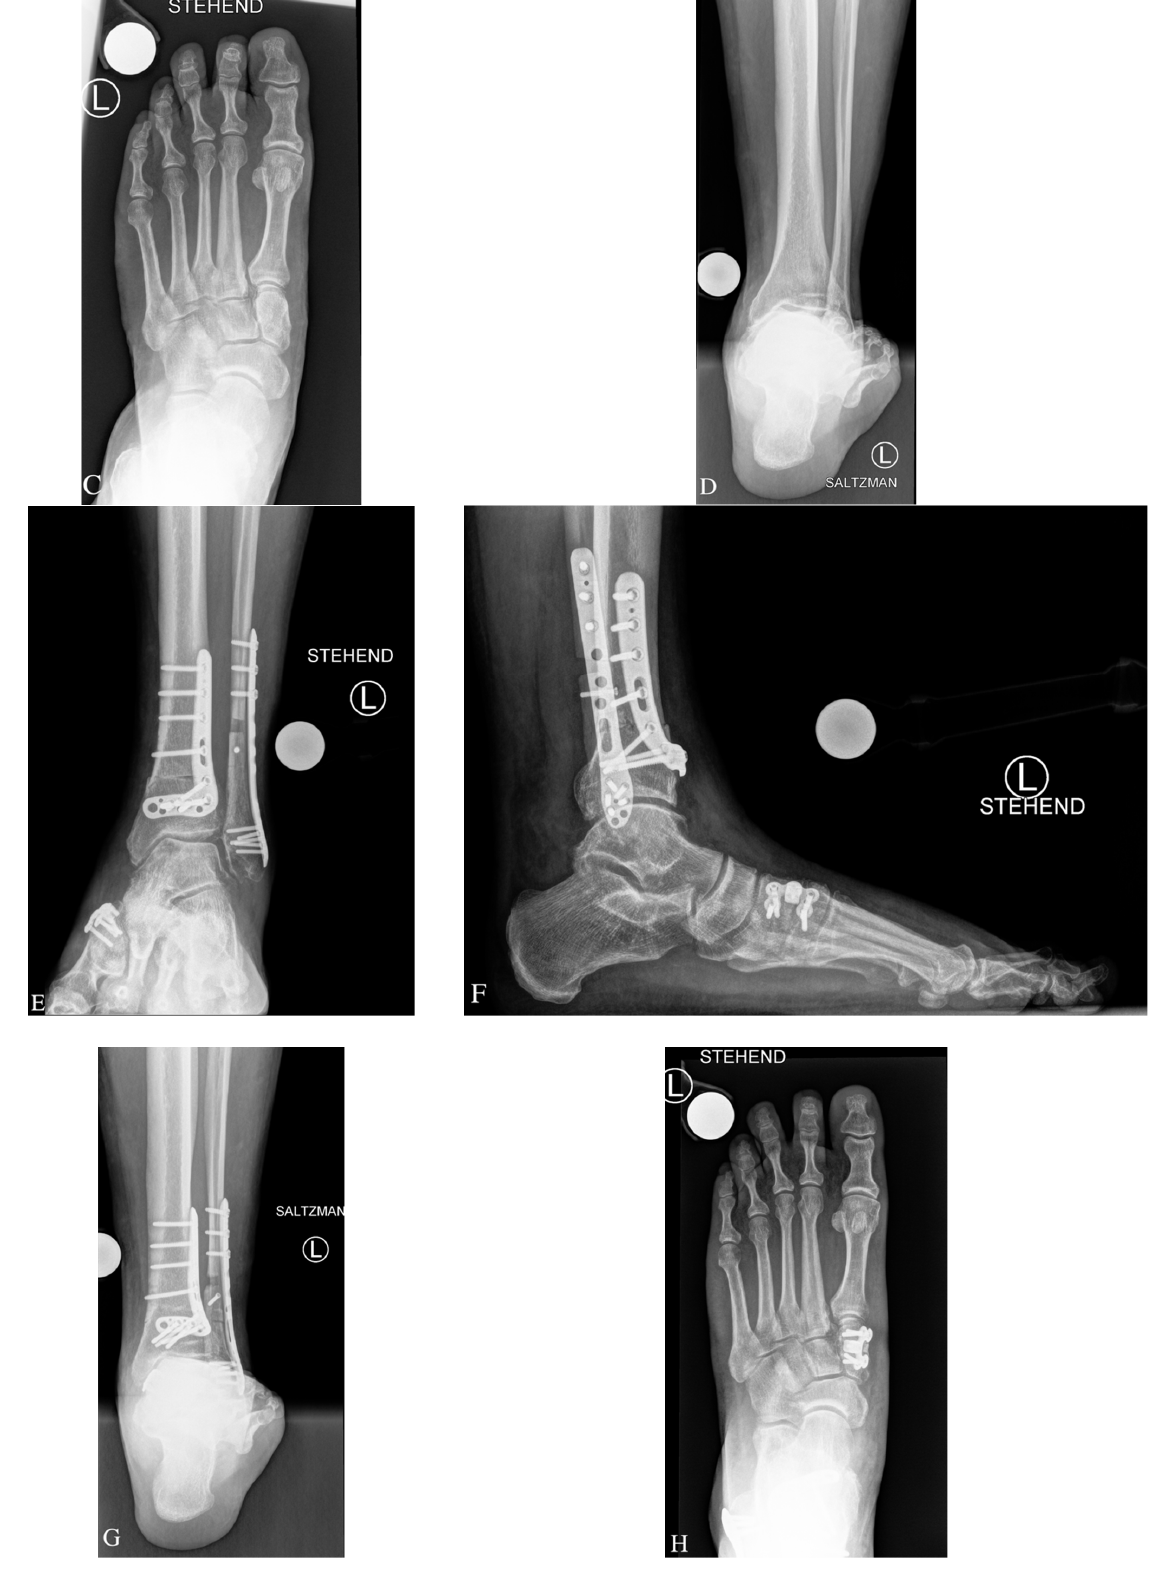
Figure 2. Chronic Painful Posttraumatic Varus Ankle Osteoarthritis (OA) with Medial Degeneration of the Ankle Joint with Pes Planus Foot. In this case, there was preoperative a varus ankle OA with